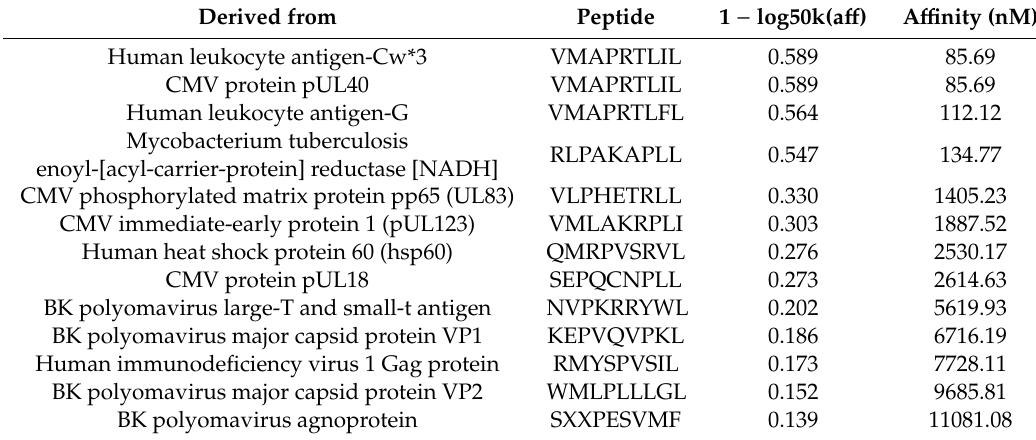
Table 6. The high a ffi nity peptide motifs reported in the literature and derived from di ff erent self or foreign antigens as well as BKPyV-derived antigens that may be presented by HLA-E*01:01 allelic variations identified by the machine-learning bioinformatics algorithm NetMHC